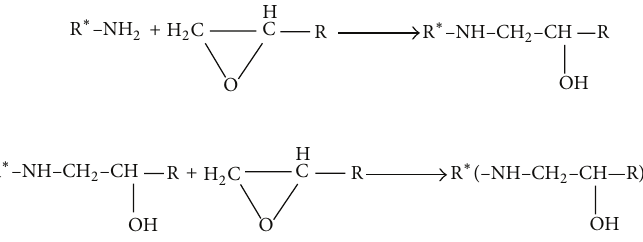
Scheme 2: Mechanism of curing epoxy resins with amine hardeners.